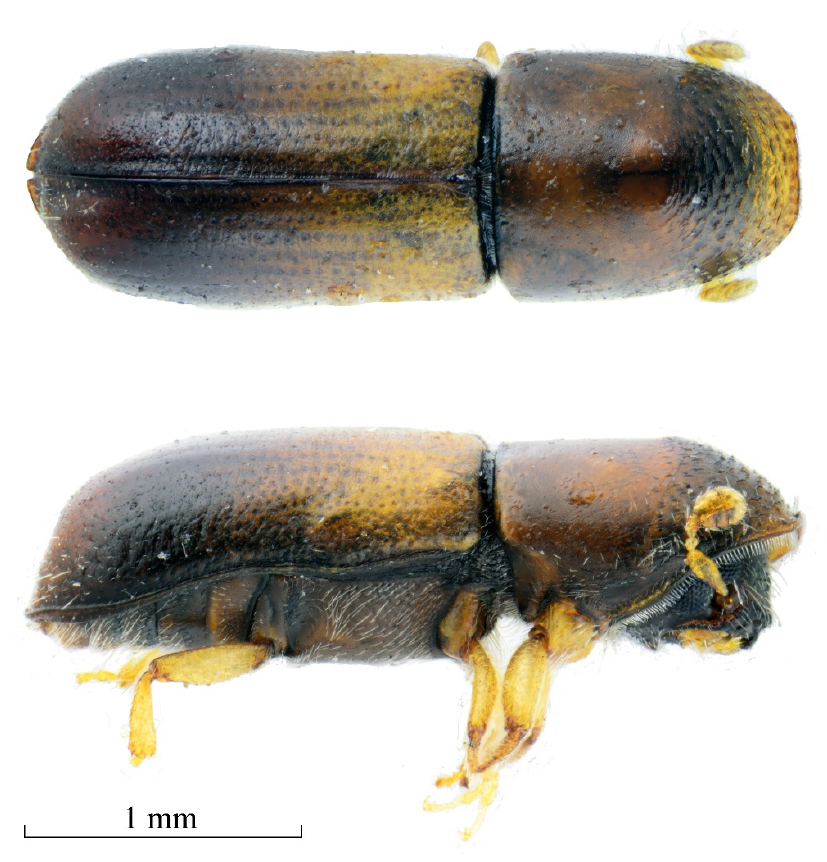
Figure 1. Dorsal and lateral view of an adult male Gnathotrichus materiarius (R. Witkowski).